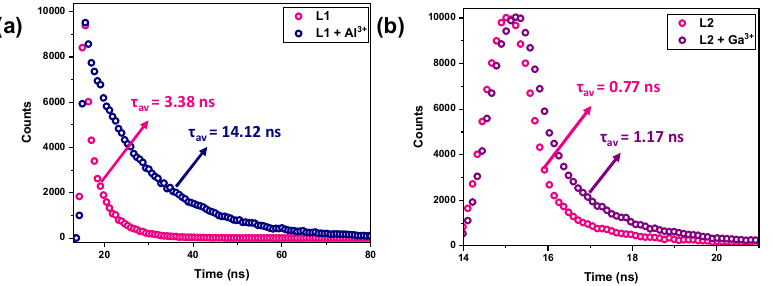
Figure 7. Lifetime profiles of chemosensors ( a ) L1 and ( b ) L2 in the absence and presence of Al 3+ and Ga 3+ ions, respectively, in EtOH.